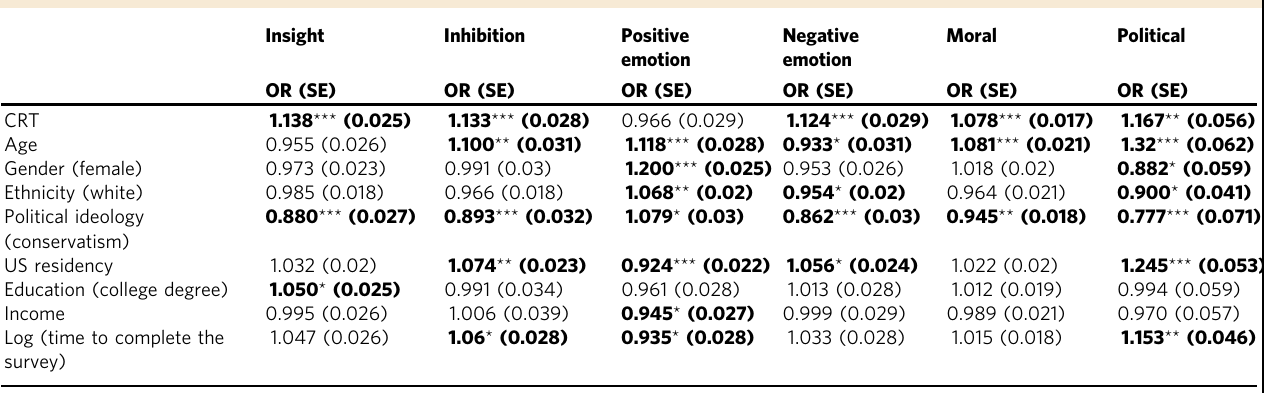
Table 5 Relationship between users ’ characteristics and the use of words in different LIWC categories in tweets.